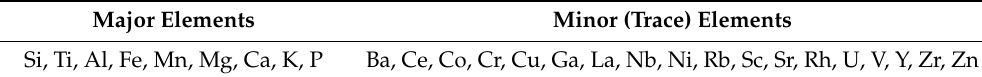
Table 3. Major and minor elements detectable by XRF for this